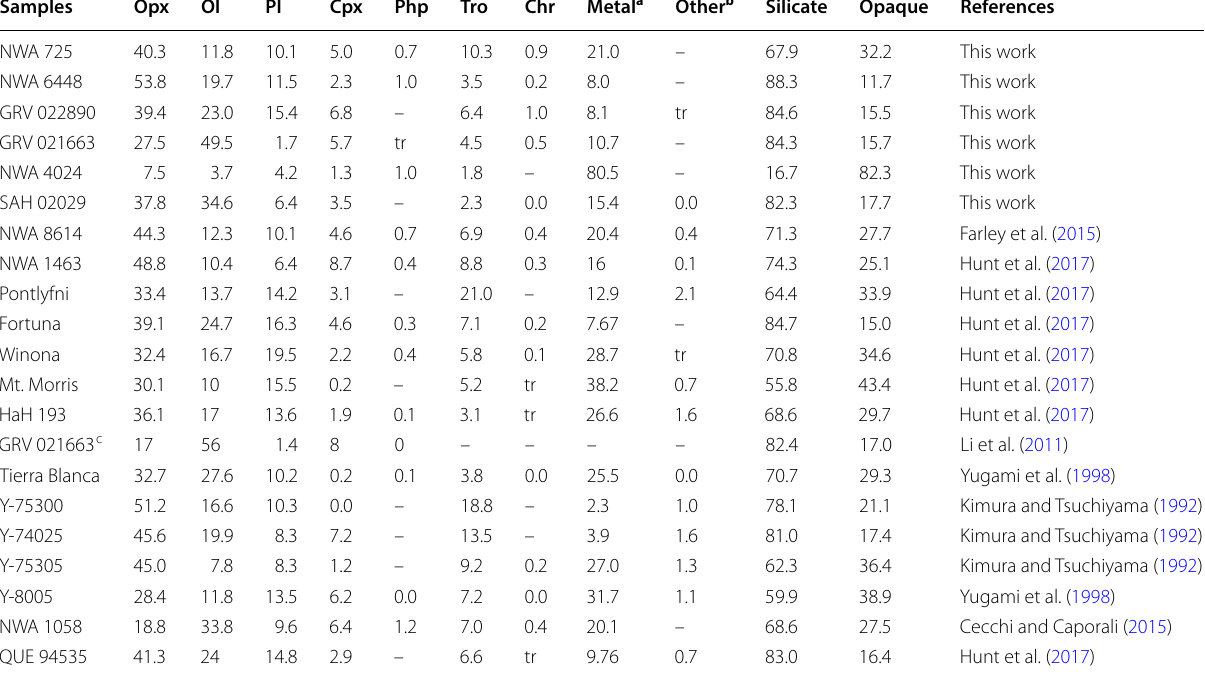
Table 1 Modal abundance of minerals in winonaites (by area,